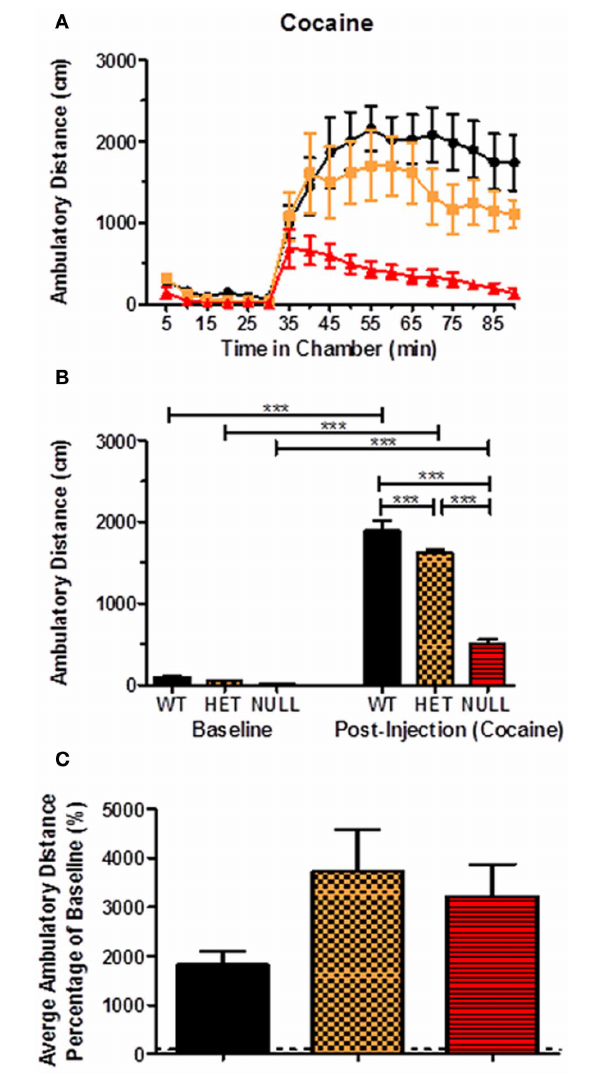
FIGURE 7 | Locomotor response to acute cocaine. We investigated the integrity of locomotor responses to variety of pharmacological compounds with the ability to modulate dopaminergic signaling (directly or indirectly) and motor output. (A) shows the ambulatory distance traveled as a function of time (5min blocks over a 90min testing period) by each genotype during a 30min baseline period and 60min after the animals were injected with cocaine (30mg/kg; i.p.). The data is represented as bar graphs in (B) with the data from min 10–30 collapsed for each genotype as the baseline measurement and min 40–60 representing the post-injection period. There is a significant increase in locomotor activity in each genotype following exposure to cocaine, however there is a significant difference between the post-injection locomotor response of the knockout mice compared to the other two genotypes [ F ( 5 , 21 ) = 186 . 0, p < 0 . 001]. The percentage change from baseline for each genotype is displayed in (C) with no significant changes. n = 6–12 for each genotype in these experiments.